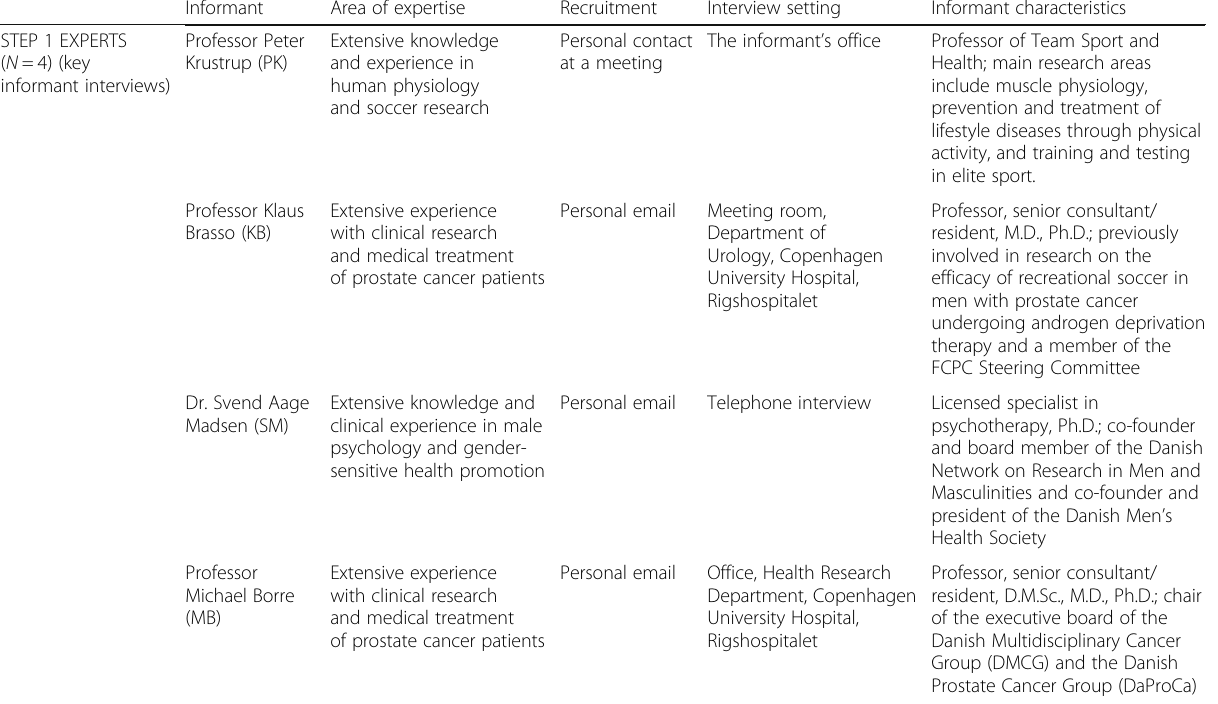
Table 1 Area of expertise, recruitment, and characteristics of key informants in step